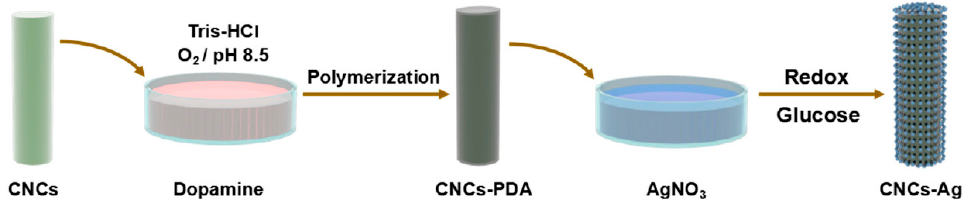
Figure 5. 3D-printed M-CMC hydrogels: ( A ) Simple cylinders and parallelepipeds (solvent: water); ( B ) The hydrogel exhibited good flexibility and handleability; ( C ) SEM analysis performed on the freeze-dried hydrogel; and 3D objects printed from water ( D ) and culture medium solution ( E,F ) [109].